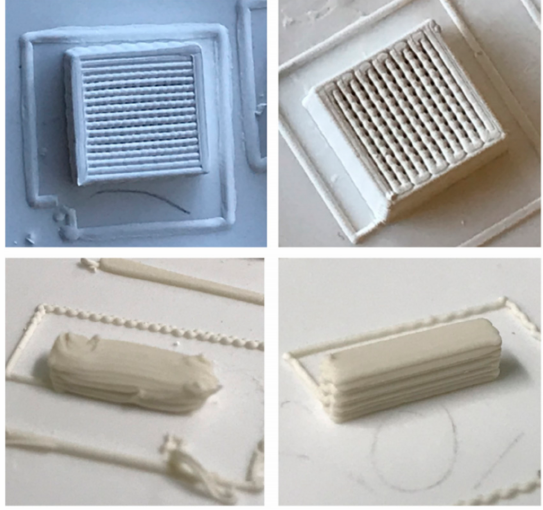
Figure 5. Effects of the overlap degrees set in the CAD model on geometrical definition of printed